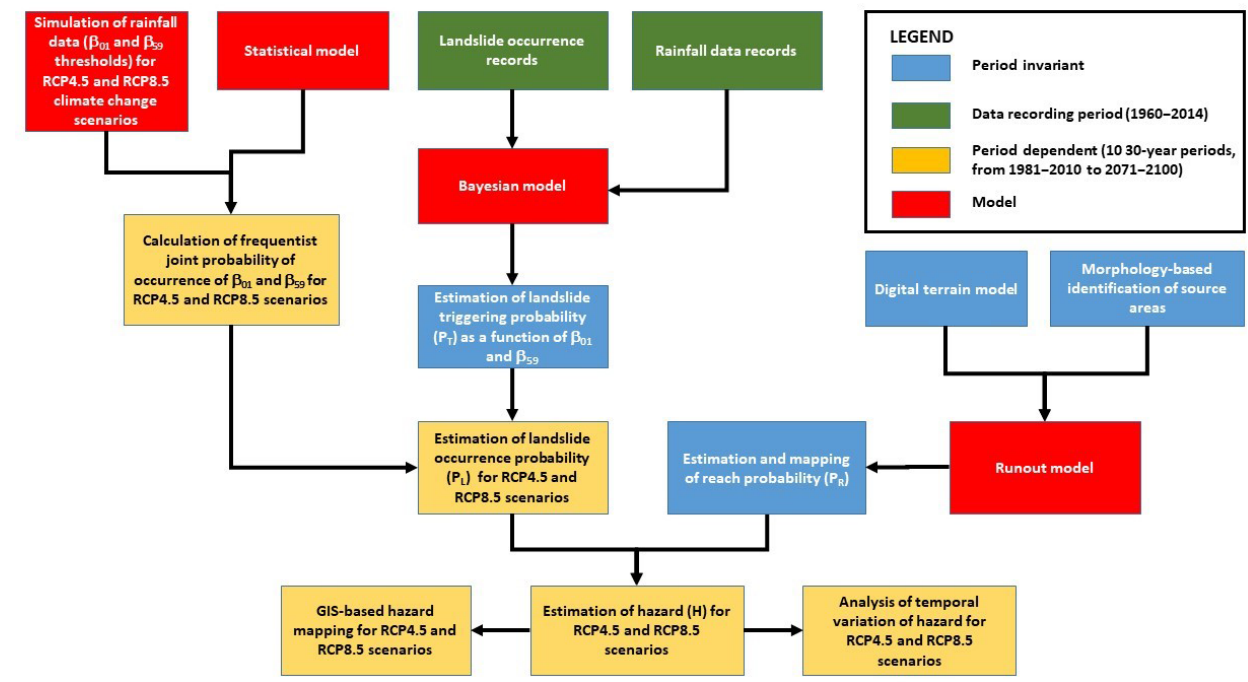
Figure 4. Operational flowchart of the